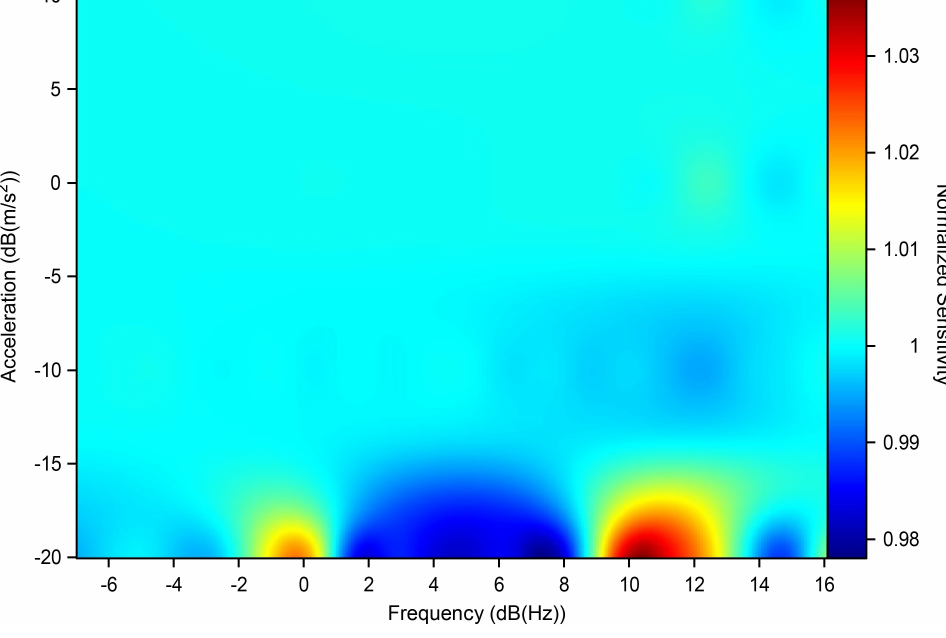
Figure 6. Variation in sensitivity as interpolation of the results obtained by shaking